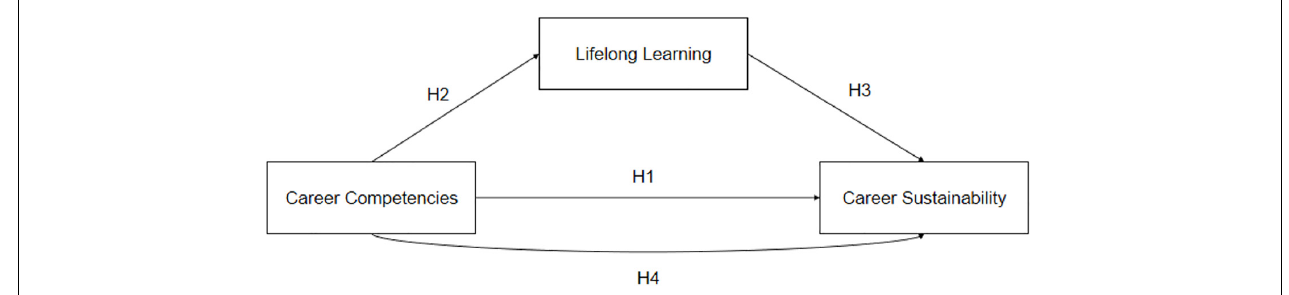
FIGURE 1 | The research